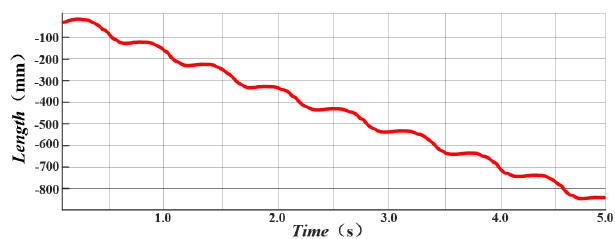
Figure 8. Displacement of the foot end in the y direction.